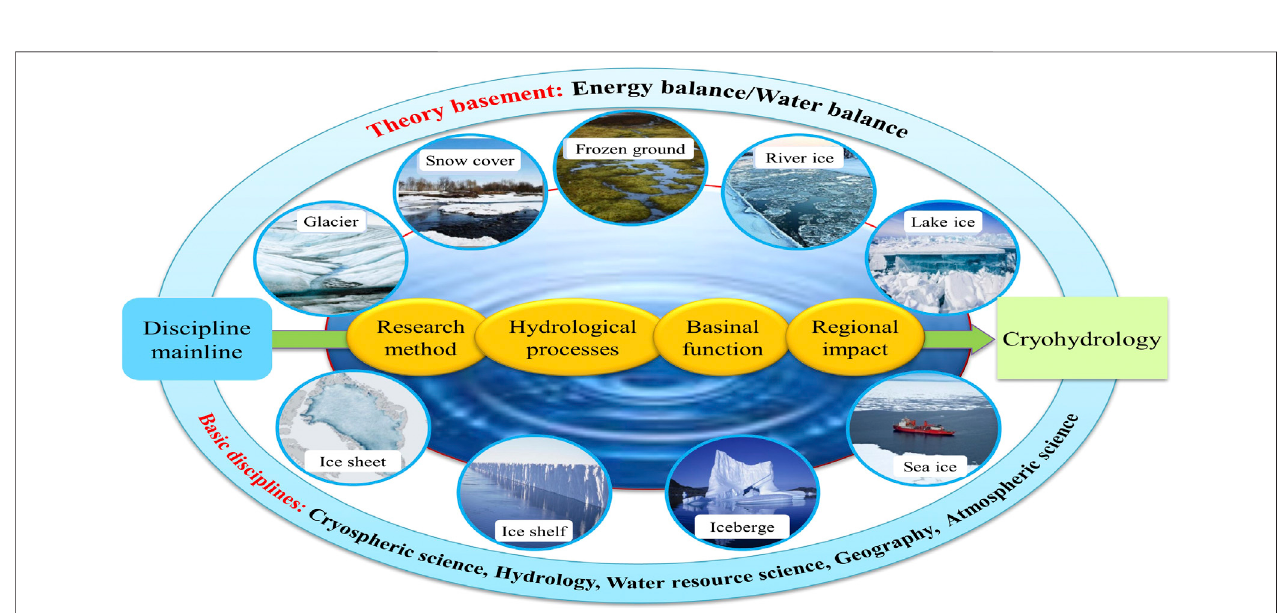
FIGURE5| Thetheorybasisandbasicdisciplinesofcryohydrologyalongthemainlinefrommethod, processes, andfunctiontoimpact ofdifferentelements ofthe cryosphere.